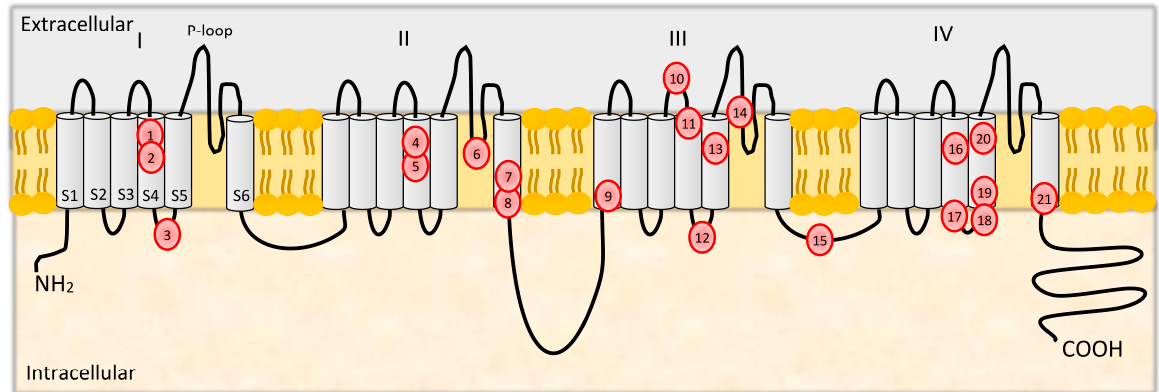
Figure 3. Locations of FHM1 mutations in the secondary structure of the calcium channel α 2.1 subunit. 1—R192Q, 2—R195K, 3—S218L, 4—V581M, 5—R583Q, 6—T666M, 7—V714A, 8—D715E, 9—Y1246C, 10—K1336E, 11—R1347Q, 12—C1370Y, 13—Y1385C, 14—V1457L, 15—C1535S, 16—R1668W, 17—L1682P, 18—W1684R, 19—V1696I, 20—I1710T, 21—I1811L. I-IV- number of extracellular loop.